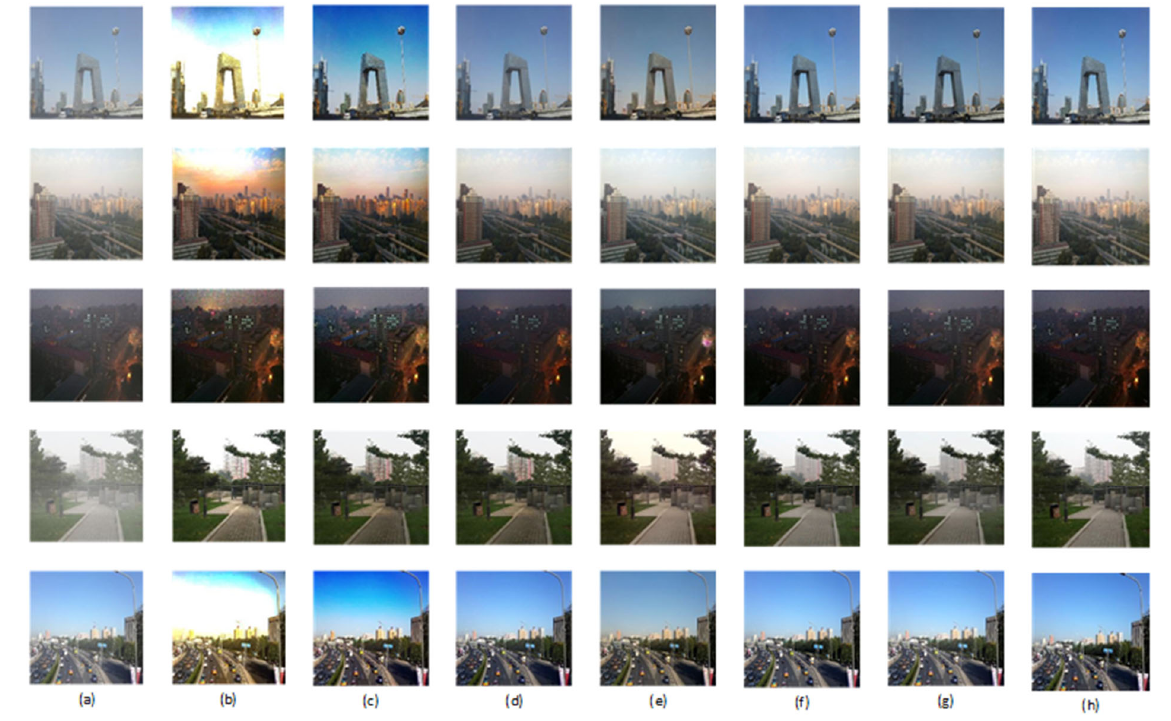
Figure 4. The experimental results of synthesizing homogeneous hazy images. ( a ) Hazy image; ( b ) method in [5]; ( c ) method in [6]; ( d ) method in [11]; ( e ) method in [12]; ( f ) method in [15]; ( g ) proposed method; ( h ) standard haze ‐ free image.